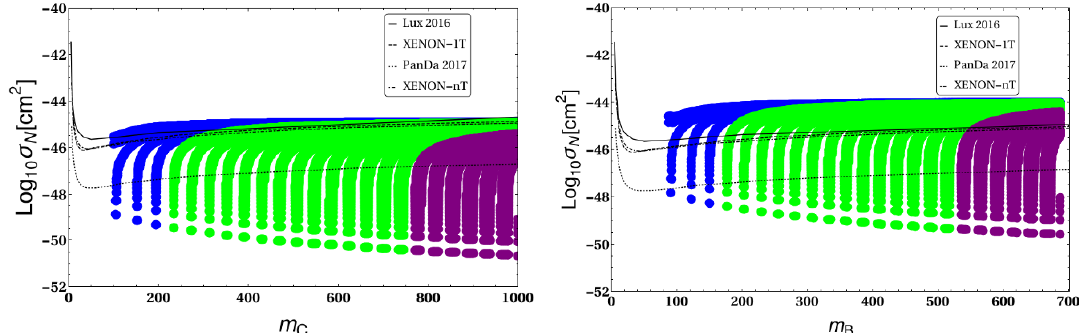
Figure 9 . Spin independent direct detection cross section for C (left) and B (right) for relic density satis(cid:12)ed region have been compared with LUX 2016 [54] and XENON 1T [55], Panda X [56] experimental constraints and with expected sensitivity from XENONnT [57]. Di(cid:11)erent choices of (cid:20) 1 are shown in di(cid:11)erent colours: 0 : 01 (cid:0) 0 : 25 (blue), 0 : 25 (cid:0) 0 : 45 (green), 0 : 45 (cid:0) 1 : 0 (purple).